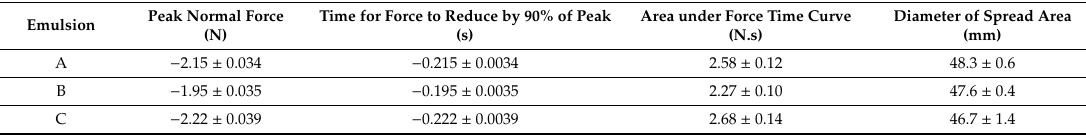
Table 2. Adhesive properties (mean ± SD, n = 6) and spreadability properties (mean ± SD, n = 3) of the gel-in-oil emulsions.